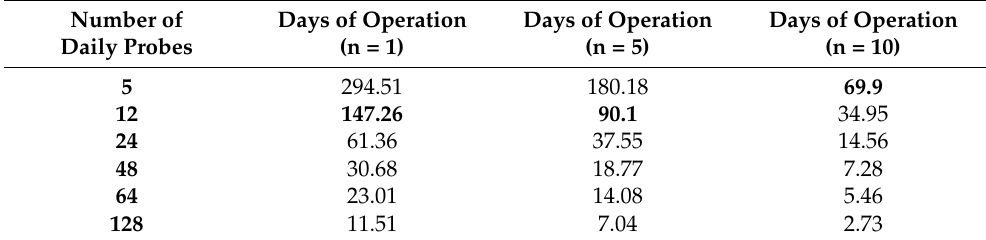
Table 5. BeeSD end-node device energy footprint. The number of daily probes in contrast to the number of nodes used per concentrator, with bold showing the values that cover the KPI 1